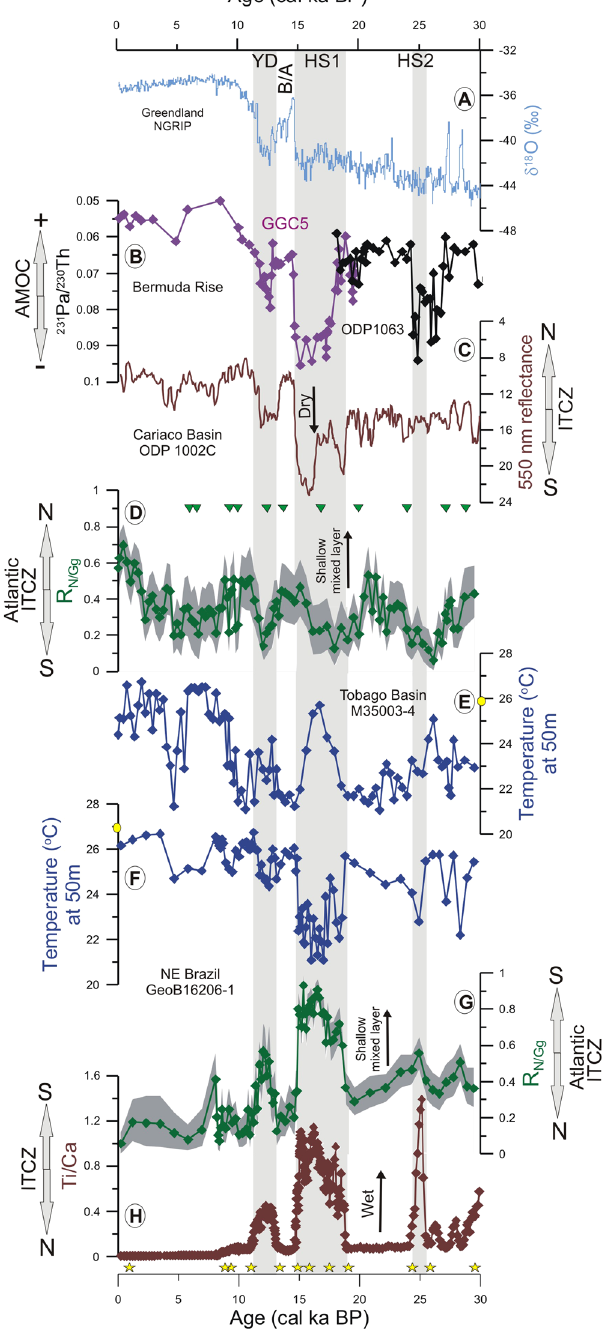
Figure 2. Antiphase relationship of the upper water column off NE-Brazil and at the Tobago Basin over the last 30 cal ka BP. ( A ) Greenland δ 18 O record 51 ; ( B ) Bermuda Rise cores GGC5 (purple) and ODP1063 (black) 231 Pa/ 230 Th as a proxy for the strength of the Atlantic Meridional Overturning Circulation (AMOC) 9, 10 ; ( C ) Cariaco Basin core ODP1002C reflectance showing wet/dry conditions linked to meridional shifts of the Intertropical Convergence Zone (ITCZ) 15 ; % Neogloboquadrina /(% Neogloboquadrina + % G. glutinata ) (R N/Gg ) ratio as a proxy for the position of the Atlantic ITCZ in the ( D ) Tobago Basin core M35003–4 and in the ( G ) NE Brazil core GeoB16206–1; Modern Analog Technique-based temperature at 50 m water depth in the ( E ) Tobago Basin and ( F) off NE Brazil; ( H ) Ti/Ca ratio as a proxy for precipitation over NE Brazil. Grey shading in ( D ) and ( G ) indicates the 95% confidence interval. Vertical gray bars indicate Heinrich Stadials 2 and 1 (HS2–1) and the Younger Dryas (YD). The Bølling–Allerød (B/A) is also indicated. Calibrated AMS 14 C ages are shown as green triangles for core M35003–4 19, 20 and yellow stars for core GeoB 16206–1 3 . Yellow circle in ( E ) and ( F ) indicate modern temperature at core locations 29 . Note the inverted axes in ( B ) and ( C